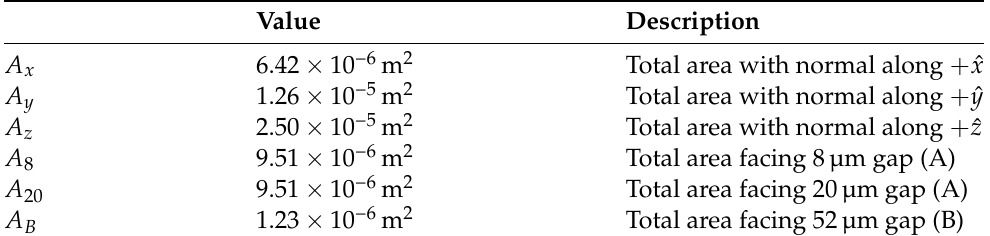
Table 1. Relevant areas in the accelerometer in Figure 1a.